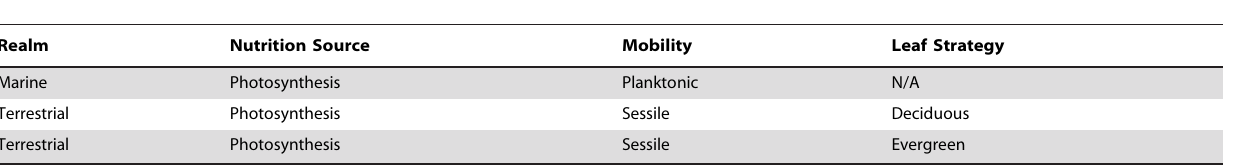
Table 1. Stock functional group